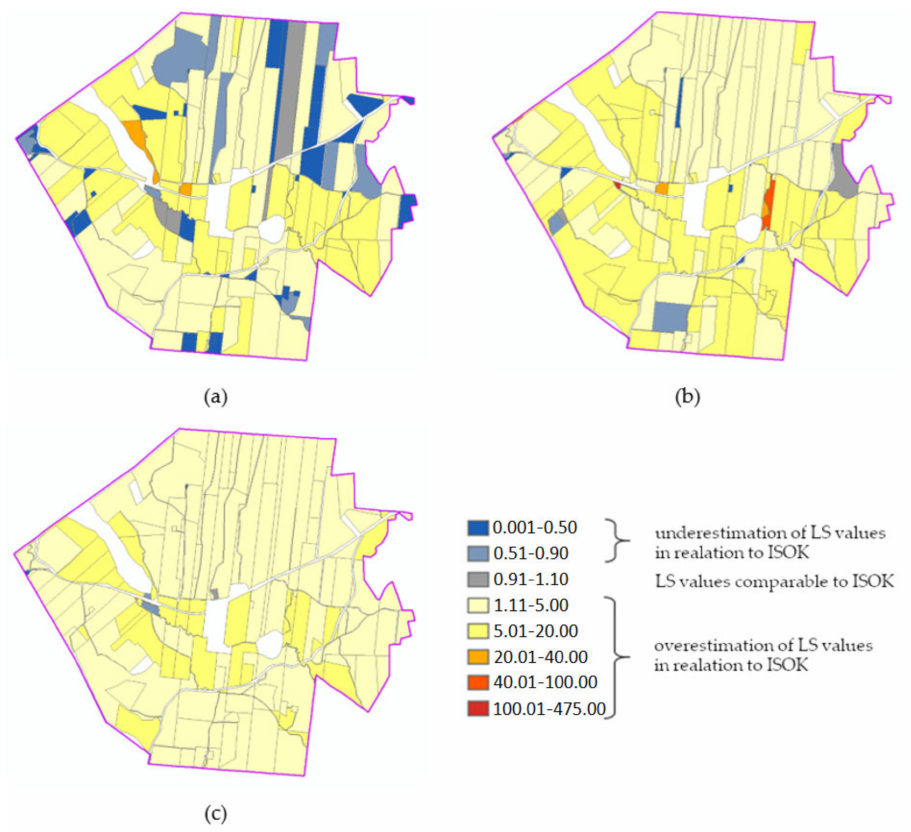
Figure 12. Comparison of the values of the variability index Wz for the sum of the total LS factor values in the plots used for agriculture obtained from the DTM SRTM ( a ), DTED2 ( b ) and LPIS ( c ) against ISOK for the Bolcie research area (additional visualisations for the Janowice and Winiarki research areas are presented in Appendix